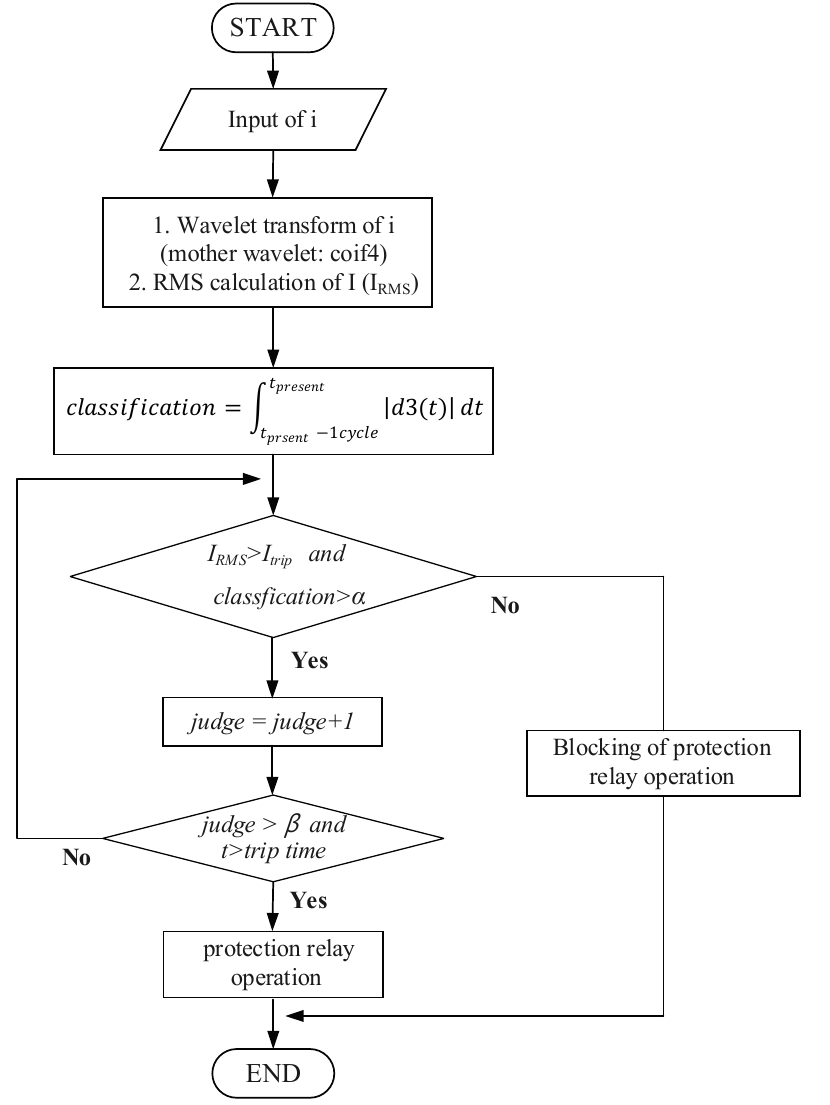
Figure 15. Flow chart of protection scheme using wavelet transform in open loop distribution system. RMS: root mean square.